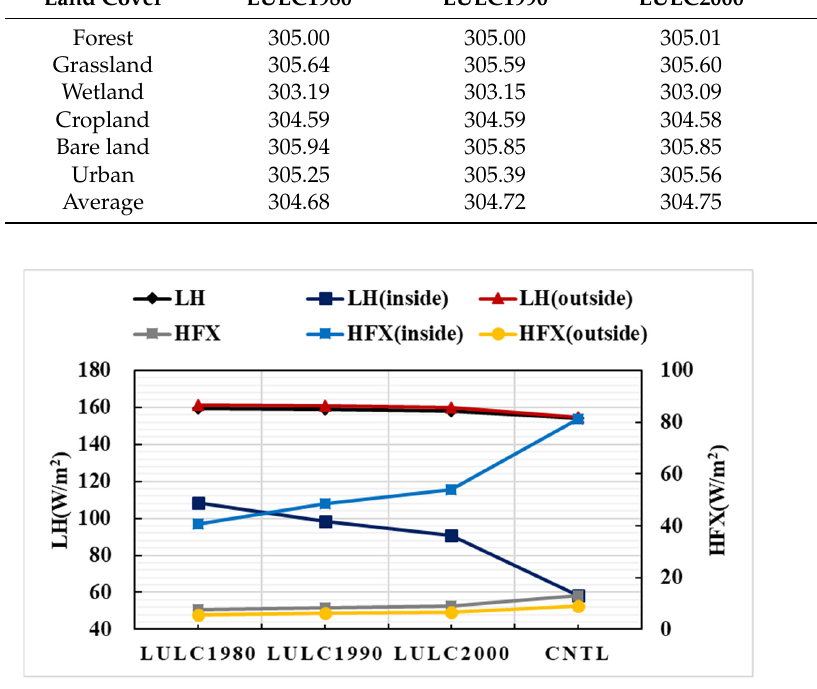
Figure 11. The averaged latent heat flux (LH, Unit: W/m 2 ) and sensible heat flux (HFX, Unit: W/m 2 ) over different statistical zones averaged from 1–15 August for the different simulation cases. LH, LH (inside) and LH (outside) (HFX, HFX (inside), and HFX (outside)) is the latent heat flux (sensible heat flux) over “the whole region of Wuhan”, over “the region within the third ring road” and “the region outside the third ring road but within the Wuhan administrative boundary”,